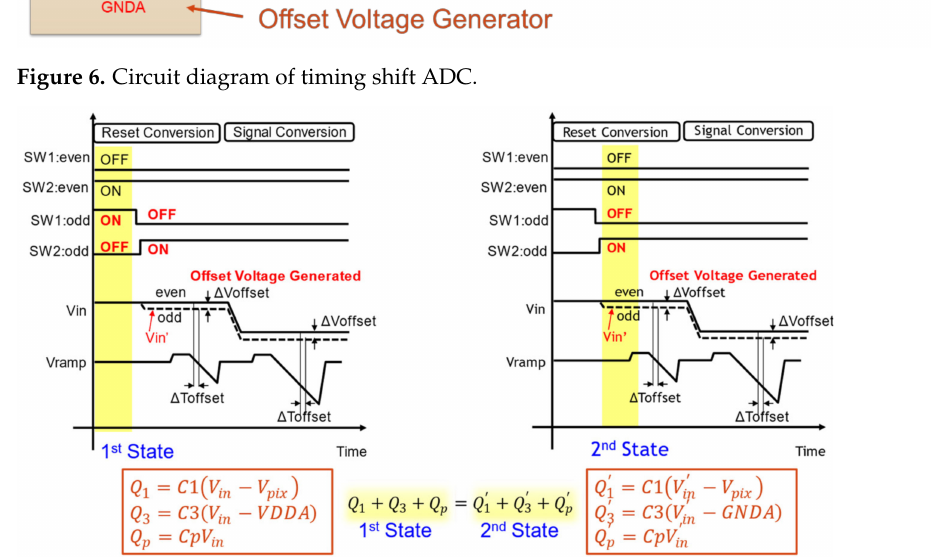
Figure 7. Generation of offset